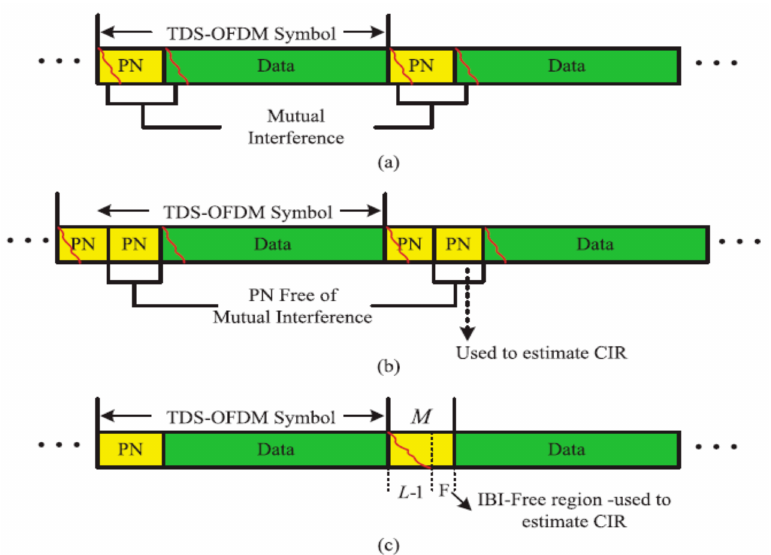
Figure 11. The frame structure of the received signal ( a ) conventional TDS-OFDM ( b ) The DPN-TDS- OFDM ( c ) TDS-OFDM based on CS